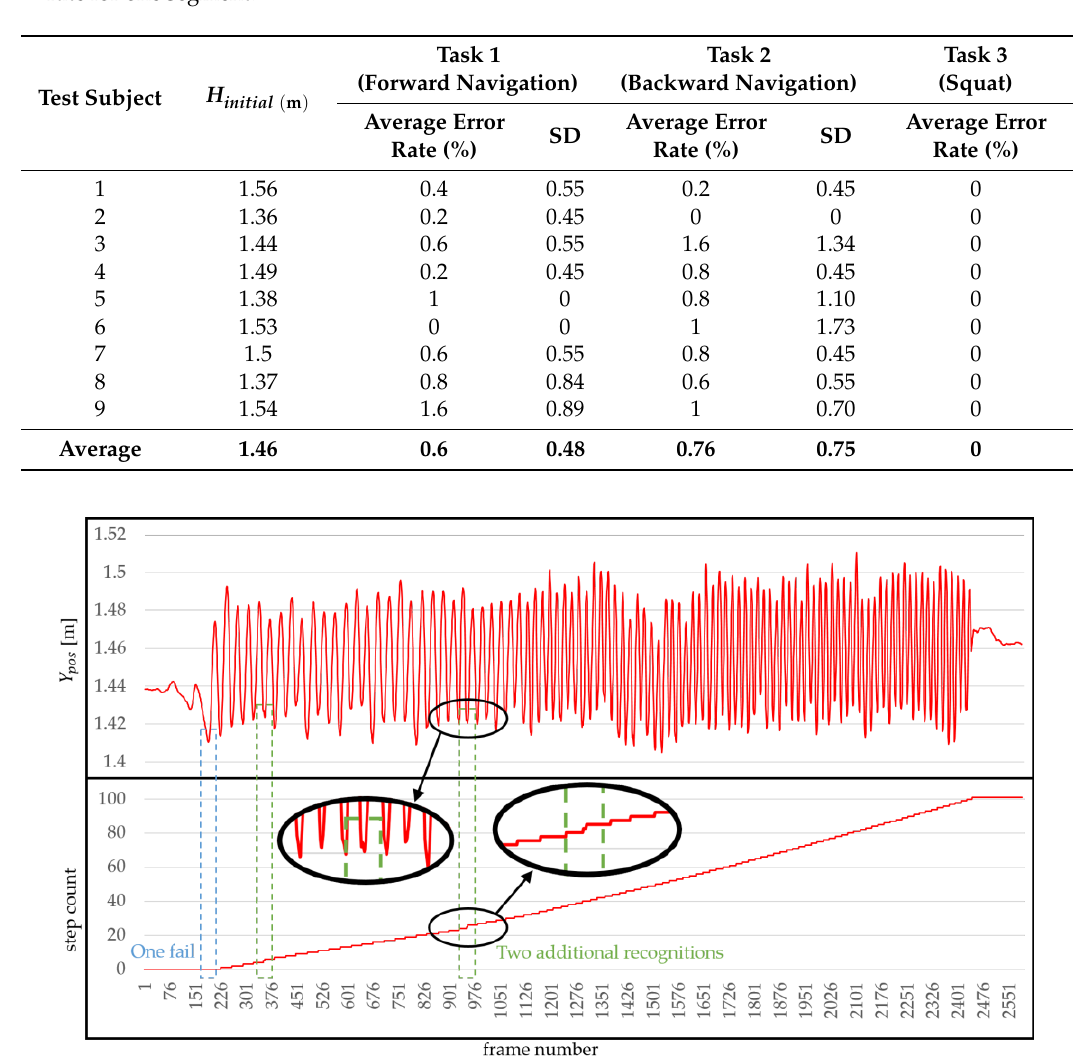
Figure 16. Evaluation result from one subject, showing 𝑌 𝑝𝑜𝑠 and step count when 101 steps are recognized. The rectangle with a blue dotted line indicates that it is not recognized, and the rectangles with a green dotted line show additional recognition.